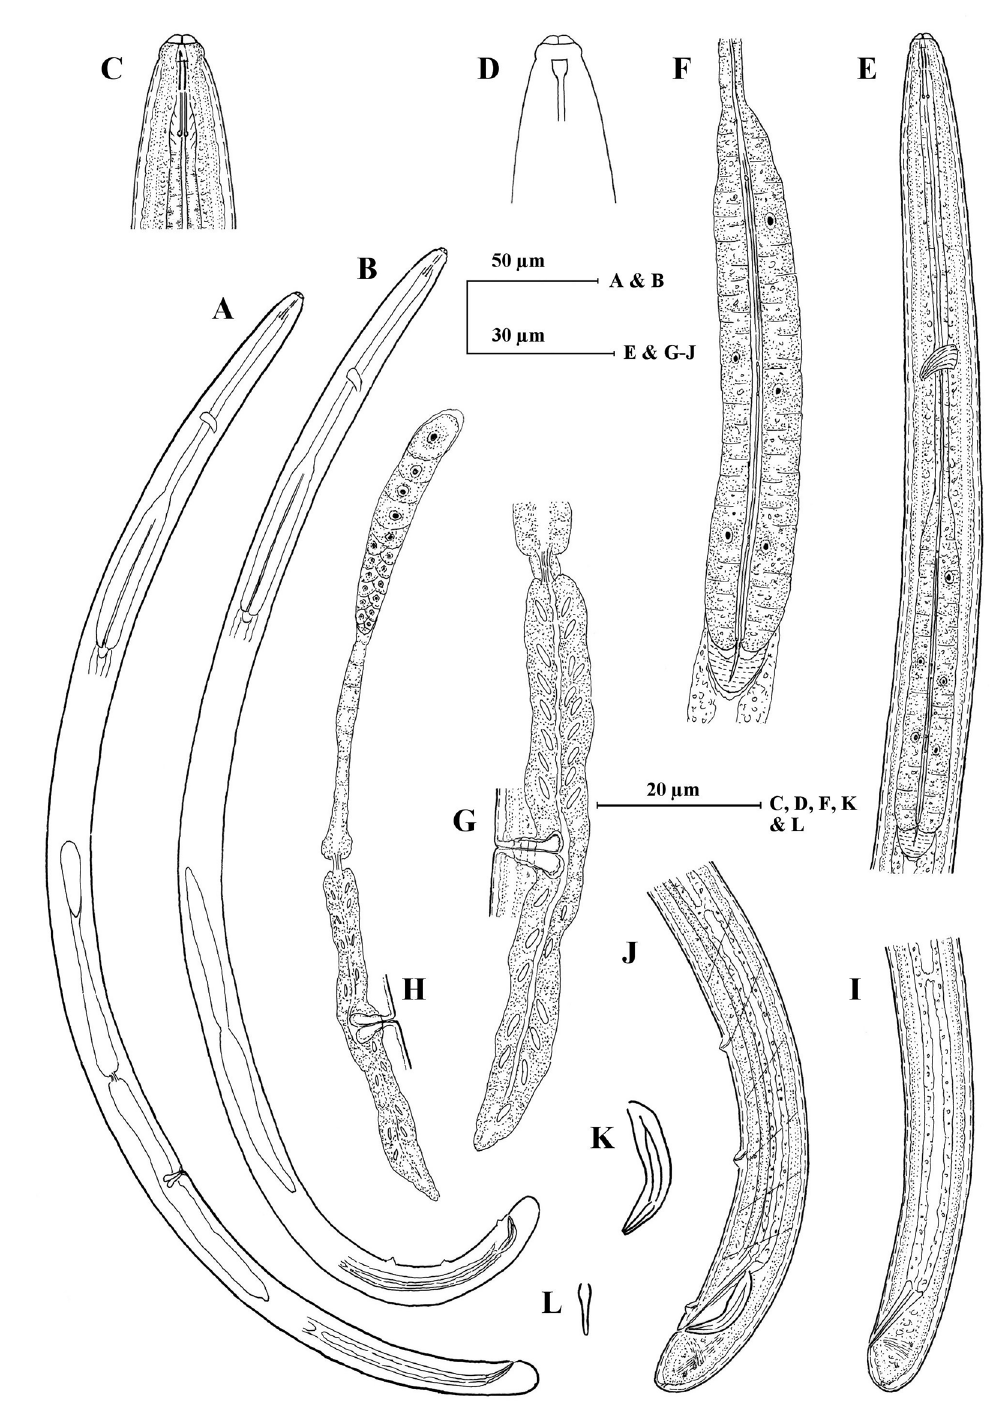
Fig. 11. Tylencholaimus southindicus sp. nov . A . Paratype 1, ♀ (slide 2). B, J–L . Paratype 11, ♂ (slide 5). C, E . Paratype 5, ♀ (slide 3). D, I . Holotype, ♀ (AMU/ZD/NC/ Tylencholaimus southindicus /1) . F . Paratype 3, ♀ (slide 2). G . Paratype 4, ♀ (slide 2). H . Paratype 13, ♀ (slide 5). A . Entire female. B . Entire male. C . Female anterior region. D . Female anterior region showing amphid. E . Female pharyngeal region. F . Female expanded part of pharynx. G–H . Female genital system. I . Female posterior region. J . Male posterior region. K . Spicule. L . Lateral guiding